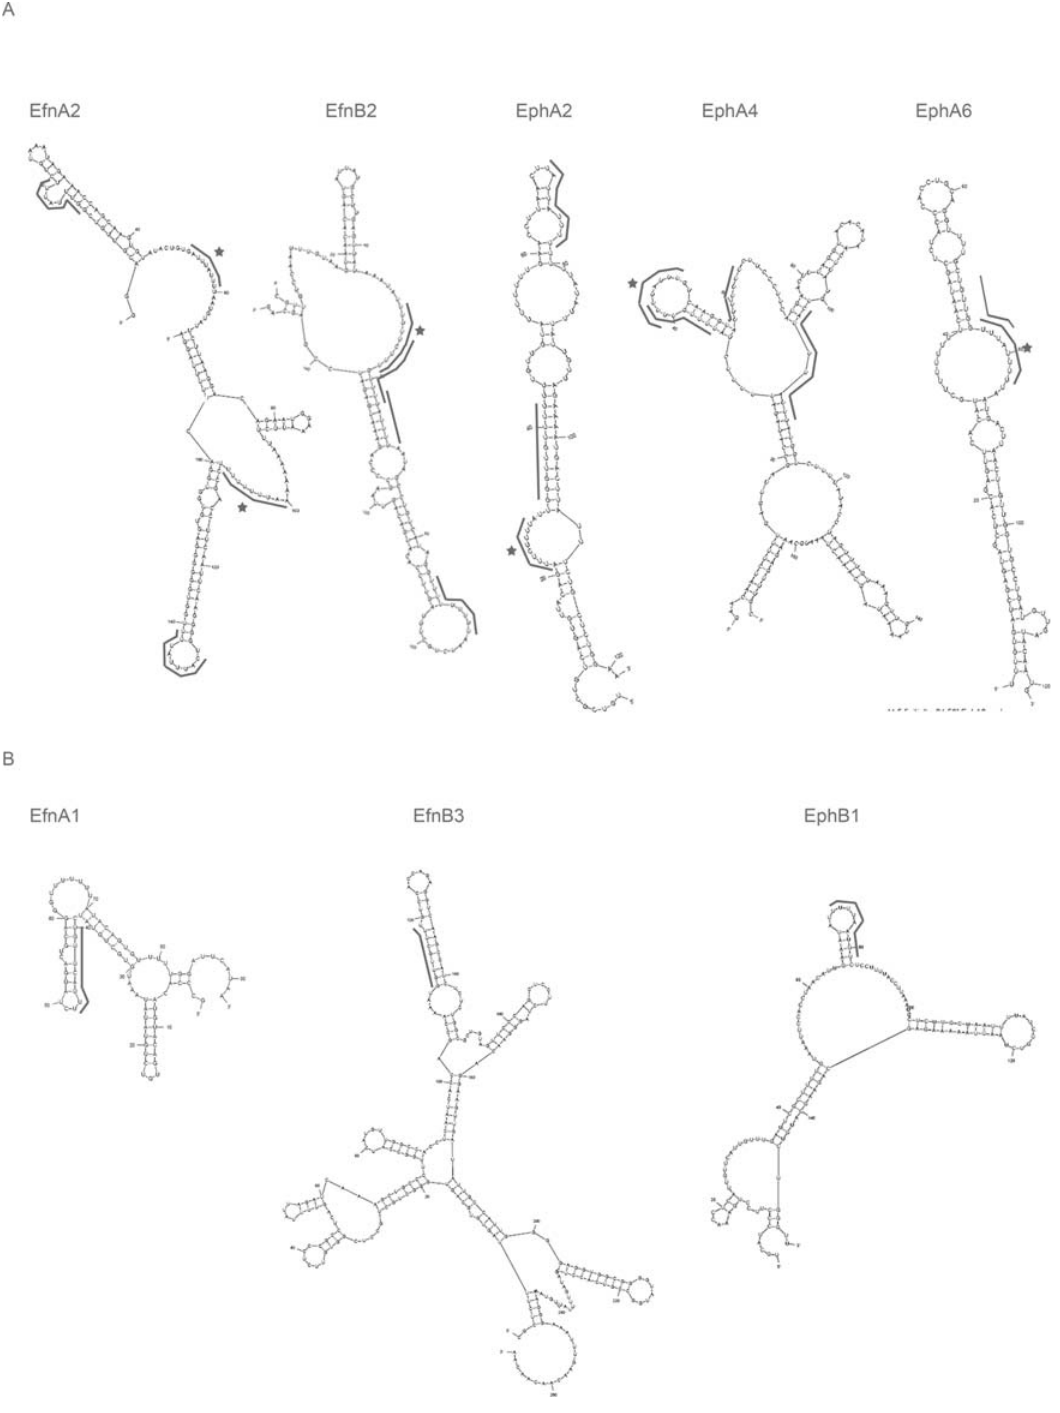
Figure 4. Secondary structures of Eph/ephrin 3’terminal parts. Shown are the secondary structures of the probes used in UV-crosslinking and RNA-protein pulldown experiments that correspond to the 3’terminal parts of Eph/ephrin 3’UTRs as predicted by Mfold. (A) Probes with HuR binding sites located in single stranded regions (asterisks) that showed high affinity binding of HuR. (B) Probes where HuR binding sites were predicted to be harboured in double stranded regions. doi:10.1371/journal.pone.0002780.g004 to human cells we immunoprecipitated HuR from the cervical ephrins in cancer cell lines and cancerous tissues, posttranscrip- carcinoma cell line HeLa and the astrocytoma/glioblastoma cell tional regulation has been neglected. Seventy-two percent of the line U373MG (Fig. 5a) using an anti-HuR antibody, and HuR binding sites of mouse Eph/ephrin 3’UTRs are conserved in performed RT-PCR on the immunoprecipitate with primers human (see above). To test if our findings in mouse cells also apply